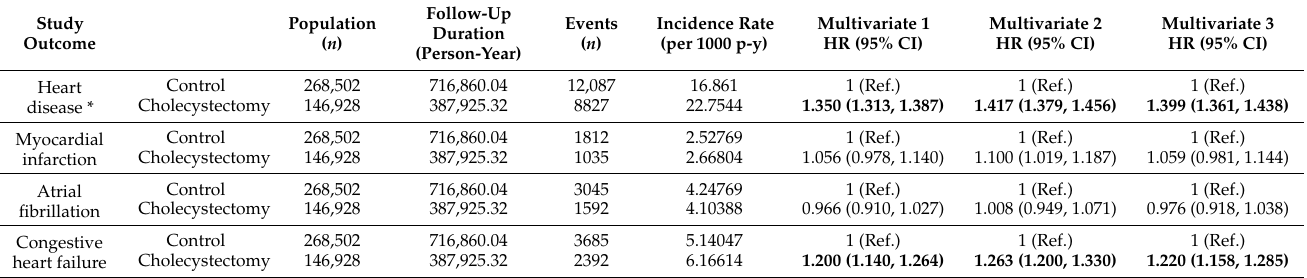
Table 2. Baseline characteristics of the matched cohort.